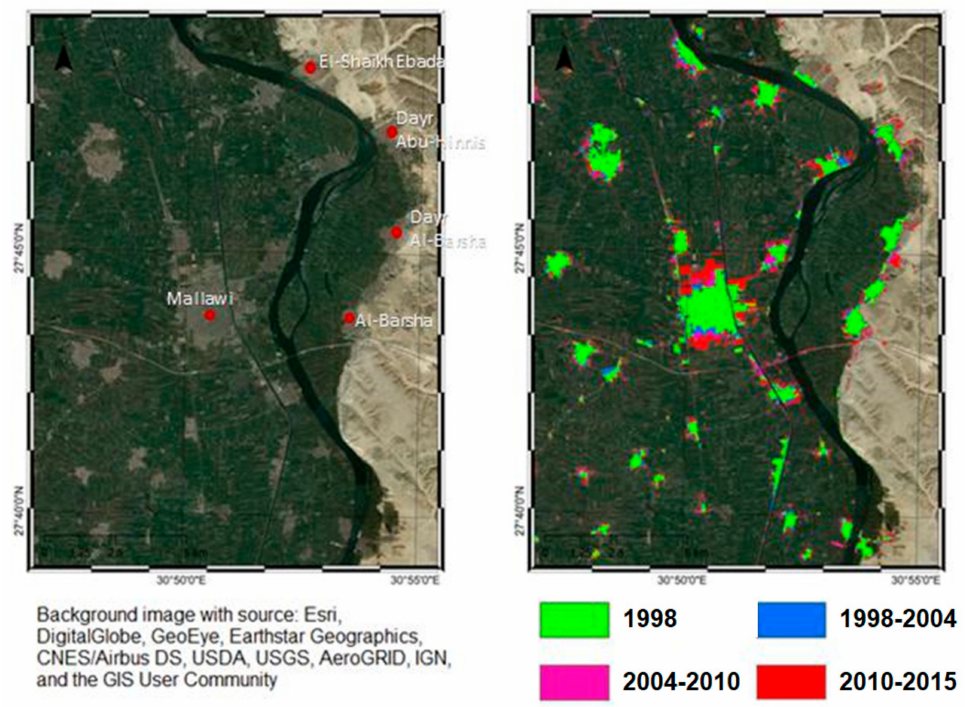
Figure 11. Urban classes detected for 1998, 2004, 2010 and 2015 in Mallawi province overlaid on optical image (right) and optical image over the area